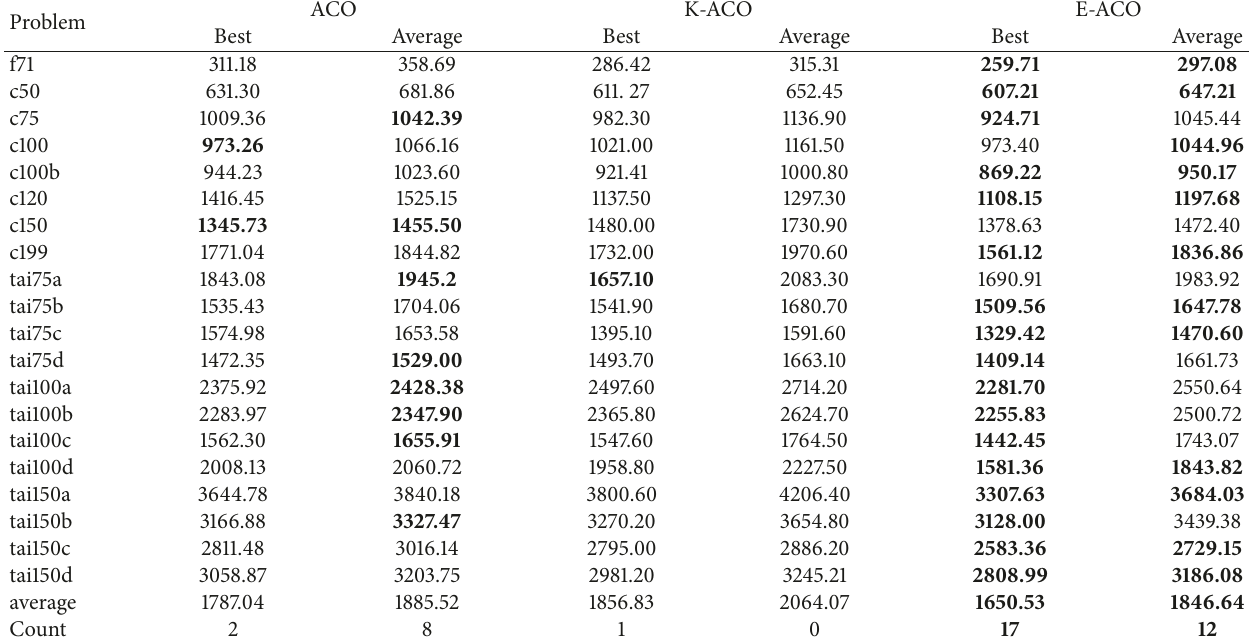
Table 2: Comparison of ACO, K-ACO, and E-ACO.